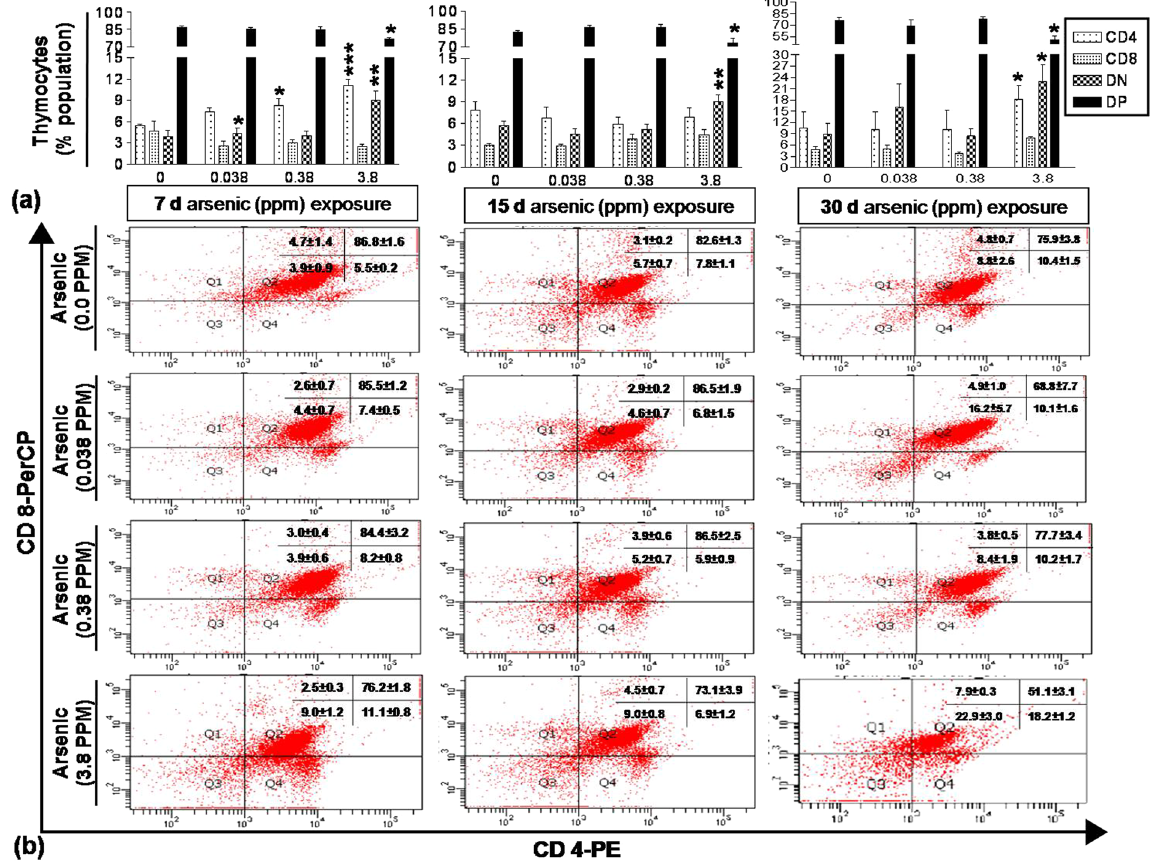
Figure 1. Effect of arsenic exposure on CD4 + T cell lineage in thymus. Thymocytes (0.2 × 10 6 ) isolated from mice treated with arsenic (0.00, 0.038, 0.38 and 3.8 ppm) orally for 7, 15 and 30 days were stained with PE conjugated anti-CD4 monoclonal antibody and PerCP conjugated anti-CD8 monoclonal antibody. The PE and PerCP fluorescence were measured using flow cytometer. ( a ) Percentage of CD4 + , CD8 + , DN (Double negative) and DP (Double Positive) thymocytes at 7, 15 and 30 days. (b) Each representative dot plot reflects thymocytes stained with CD4 and CD8 antibodies. Exposure to arsenic promoted commitment of double positive thymocytes into CD4 + T cells. Values are mean ± S.E. (n = 9 per group). * p < 0.05, ** p < 0.01 and *** p < 0.001 compared to